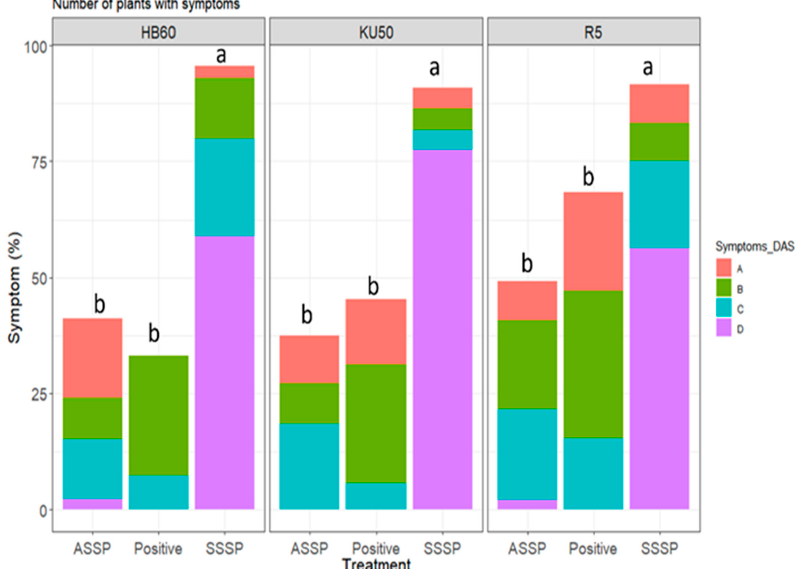
Figure 1. Cumulative number of CMD symptomatic plants (%) per plot 30 (D), 65 (C), 156 (B) and 278 (A) days after planting (DAP) of 3 cassava varieties commonly grown in Southeast Asia. Three kinds of stakes/seeds were planted, positive selection (visually no disease symptoms), Asympto- matic stem from symptomatic plants (ASSP) and symptomatic stems from symptomatic plants (SSSP). Bars with different letters are significantly different ( p <